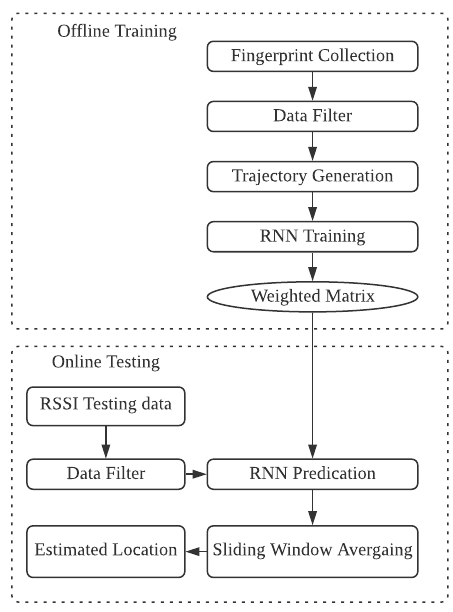
Figure 11. Location Estimation process of RNN